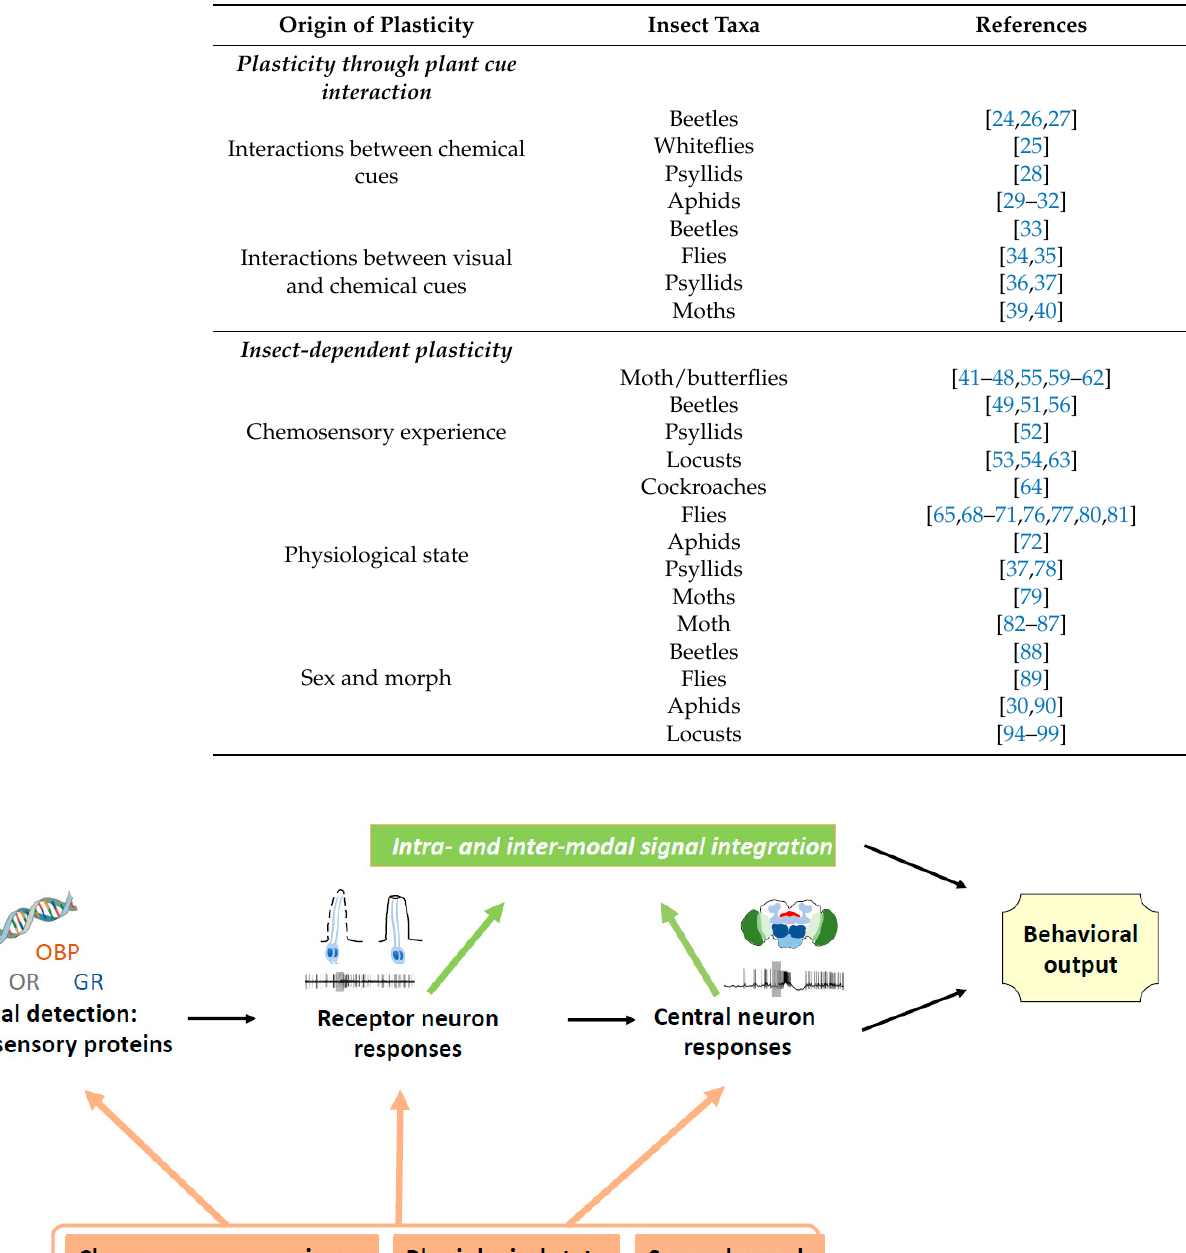
Table 1. Literature overview over different origins of chemosensory plasticity in host plant recognition of herbivorous insects.